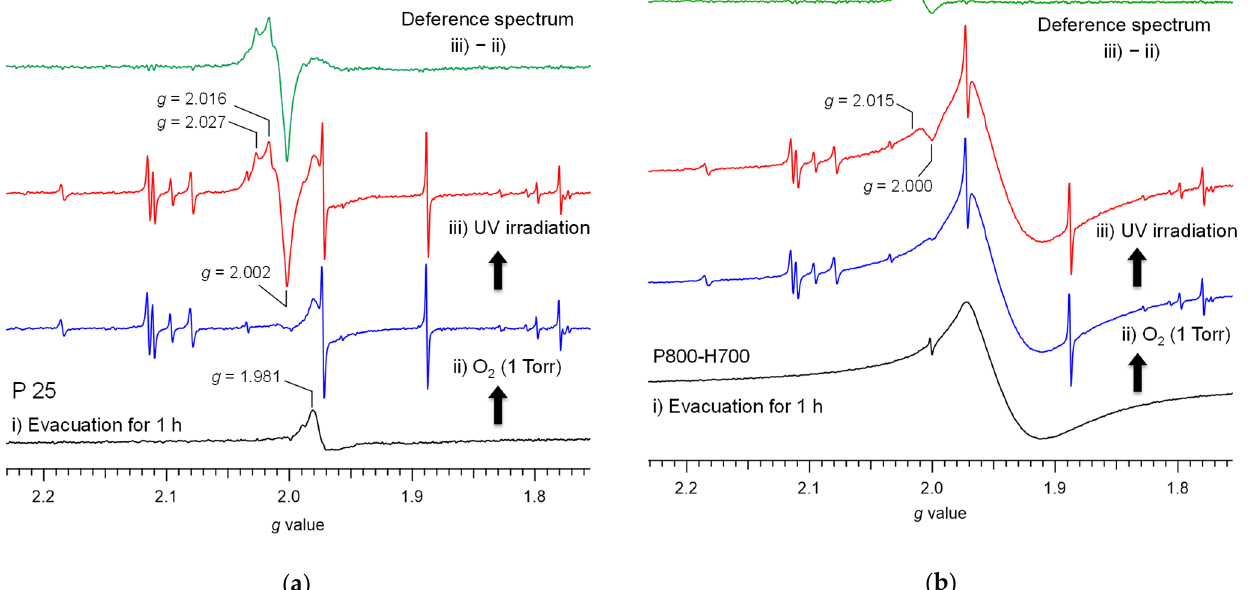
Figure 7. ESR spectra at − 150 °C of ( a ) P 25 and ( b ) P800-H700. The sample was measured after (i) evacuation at 25 °C for 1 h, (ii) introduction of 1.0 Torr of oxygen, and (iii) UV irradiation with oxygen. The difference spectra between before and after photoirradiation are also shown.